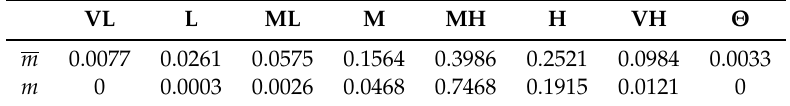
Table 9. The weighted average evidence and combination result of middle level criteria.